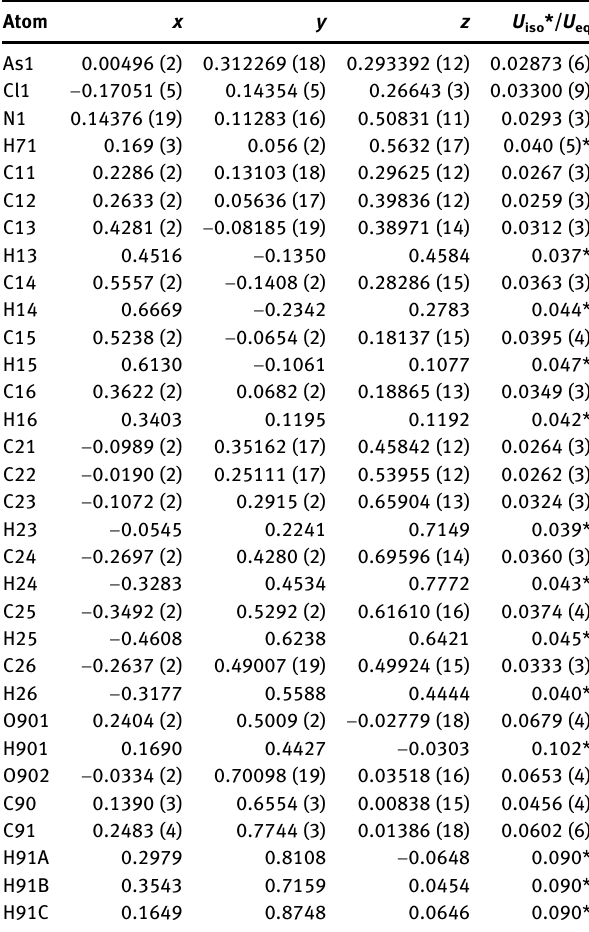
Table  : Fractional atomic coordinates and isotropic or equivalent isotropic displacement parameters (Å  ).